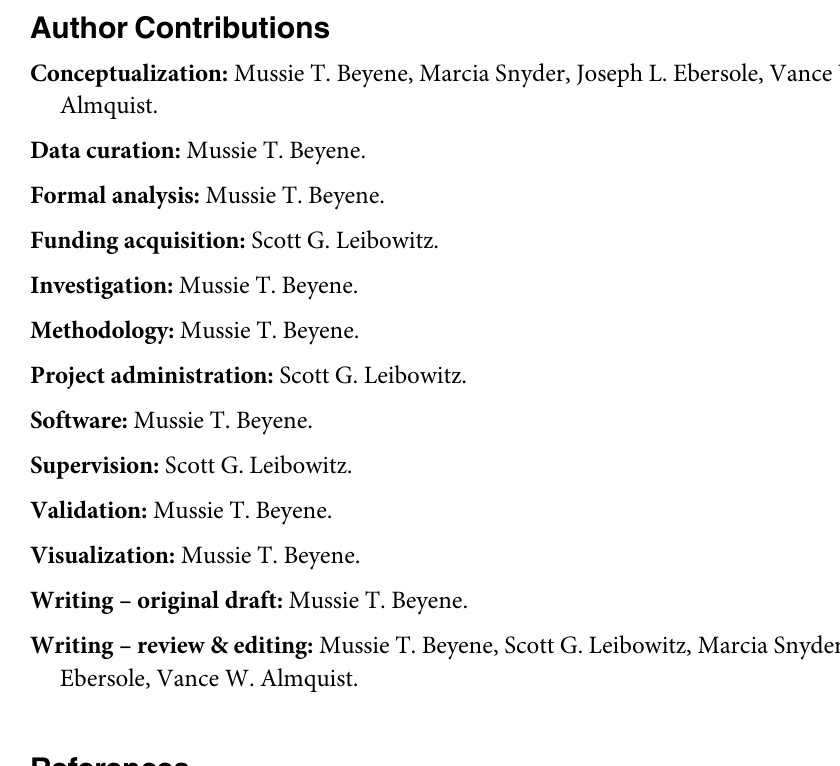
S1 Table. Summary of dataset attributes and sources used for this